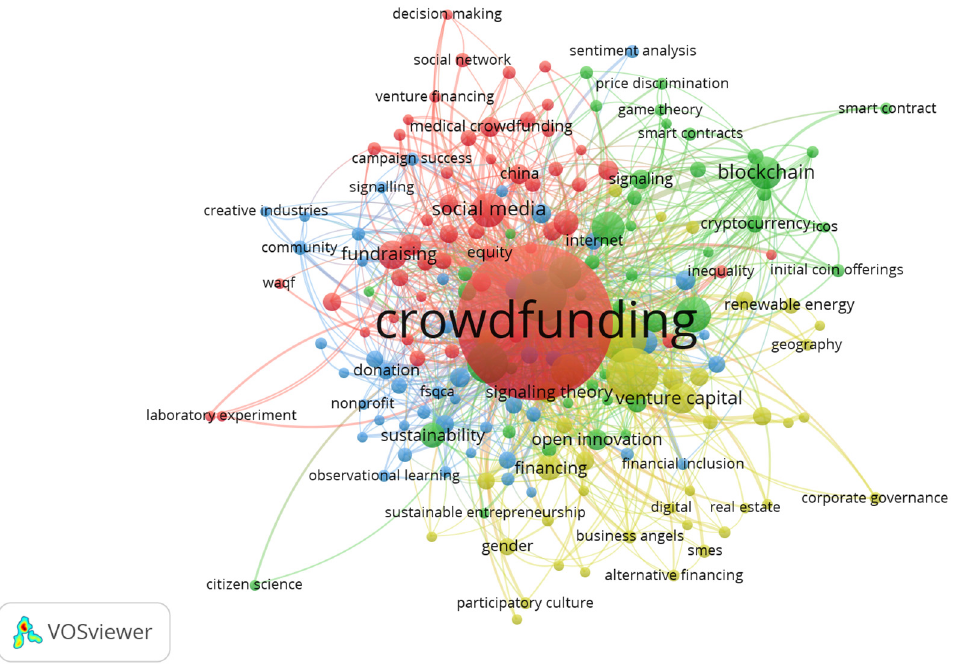
Figure 12. Co-occurrence of keywords analysis.